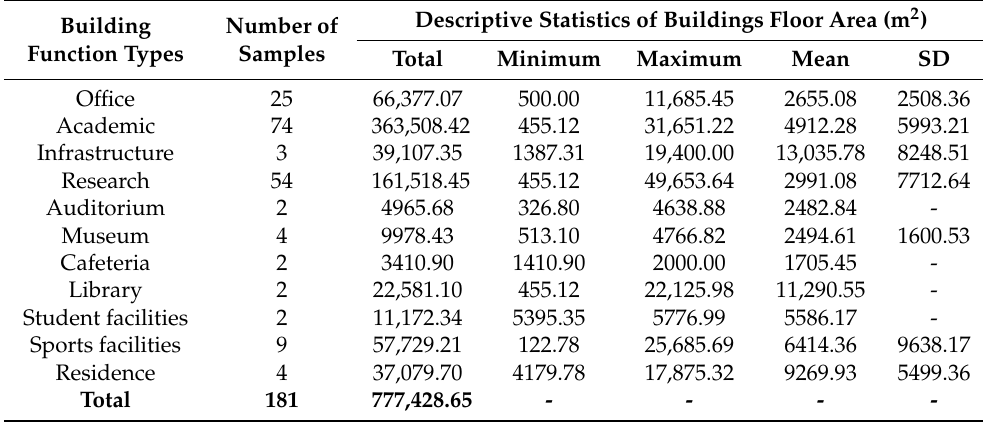
Table 2. Basic information of energy meter record samples based on building function